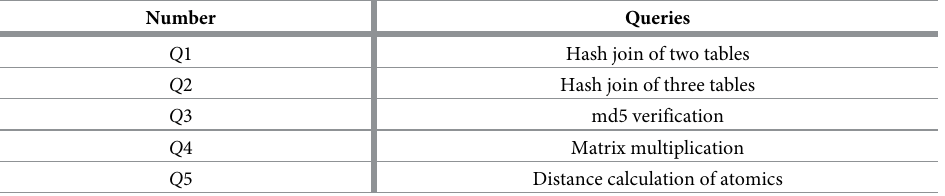
Table 1. Queries in benchmark.